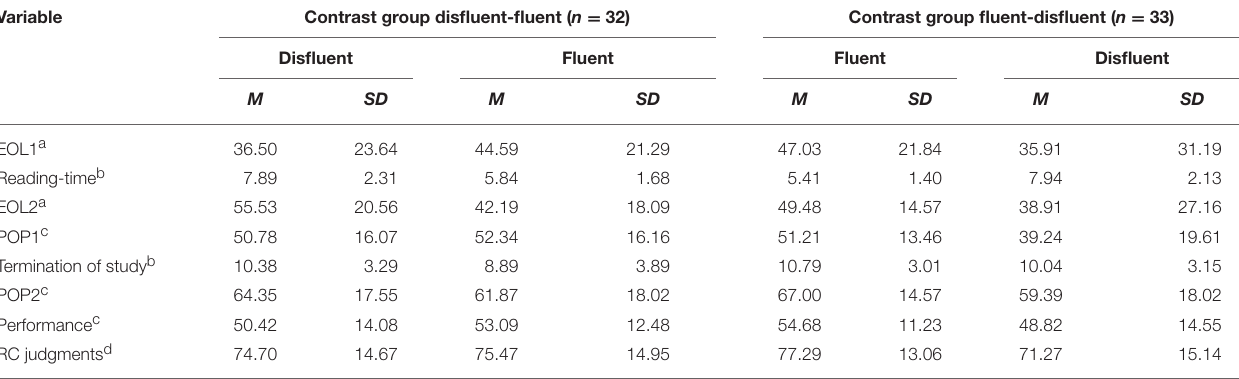
TABLE 1 | Descriptive statistics of dependent variables in contrast group disfluent-fluent and in contrast group fluent-disfluent.